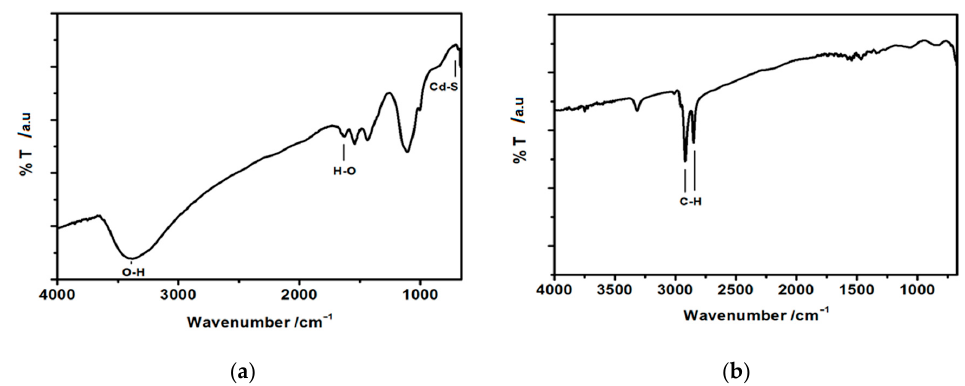
Figure 4. Fourier-transform infrared spectra (FT-IR) spectra of ( a ) hydrophilic, uncoated CdS nanoparticles and ( b ) hydrophobic, oleylamine-capped CdS nanoparticles.